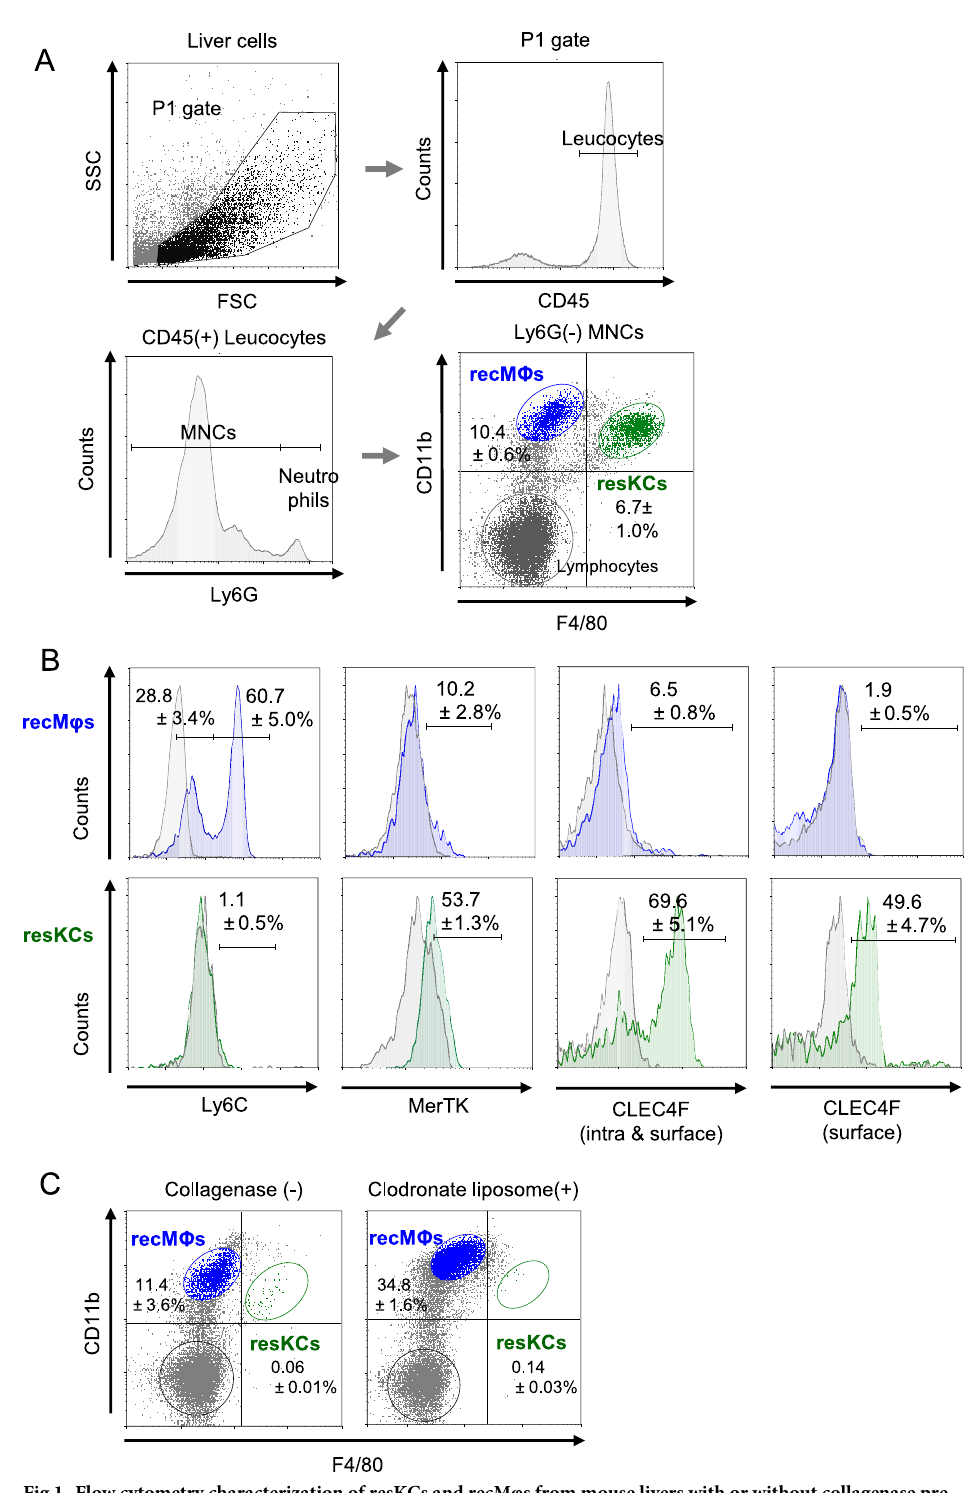
Fig 1. Flow cytometry characterization of resKCs and recM φ s from mouse livers with or without collagenase pre- treatment. (A) Gating strategy of liver recM φ s and resKCs with four-color analysis. Livers from B6 mice were minced and treated with collagenase. Non-parenchymal cells were extracted and subjected to flow cytometry analysis. The extracted cells were gated with FSC and SSC, and CD45-positive immune cells were selected. Ly6G-negative cells, excluding neutrophils, were used for the experiments. Based on FACS analysis of F4/80 and CD11b expression, F4/